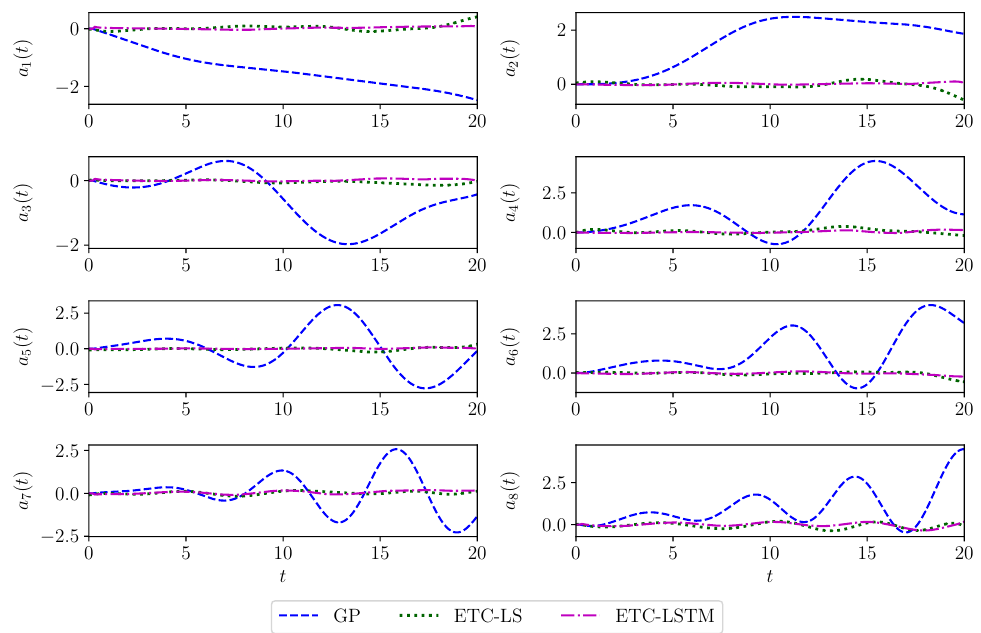
Figure 7. Evolution of the error with respect to true vorticity modal coefficients at Re = 1000 with γ =